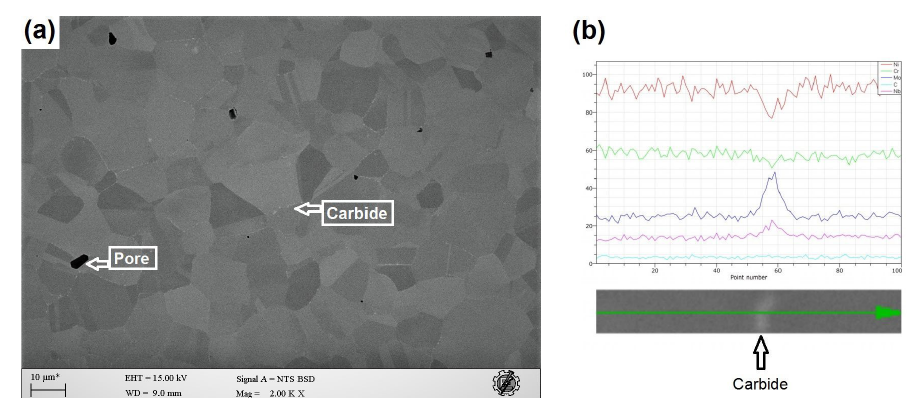
Figure 2. Inconel 625 superalloy forged, annealed (800 °C/2 h/air cooling) and solutioned at 1150 °C for 2 h: (a) Microstructure (SEM/BSE) and (b) Compositional profile of the carbide at the grain boundary